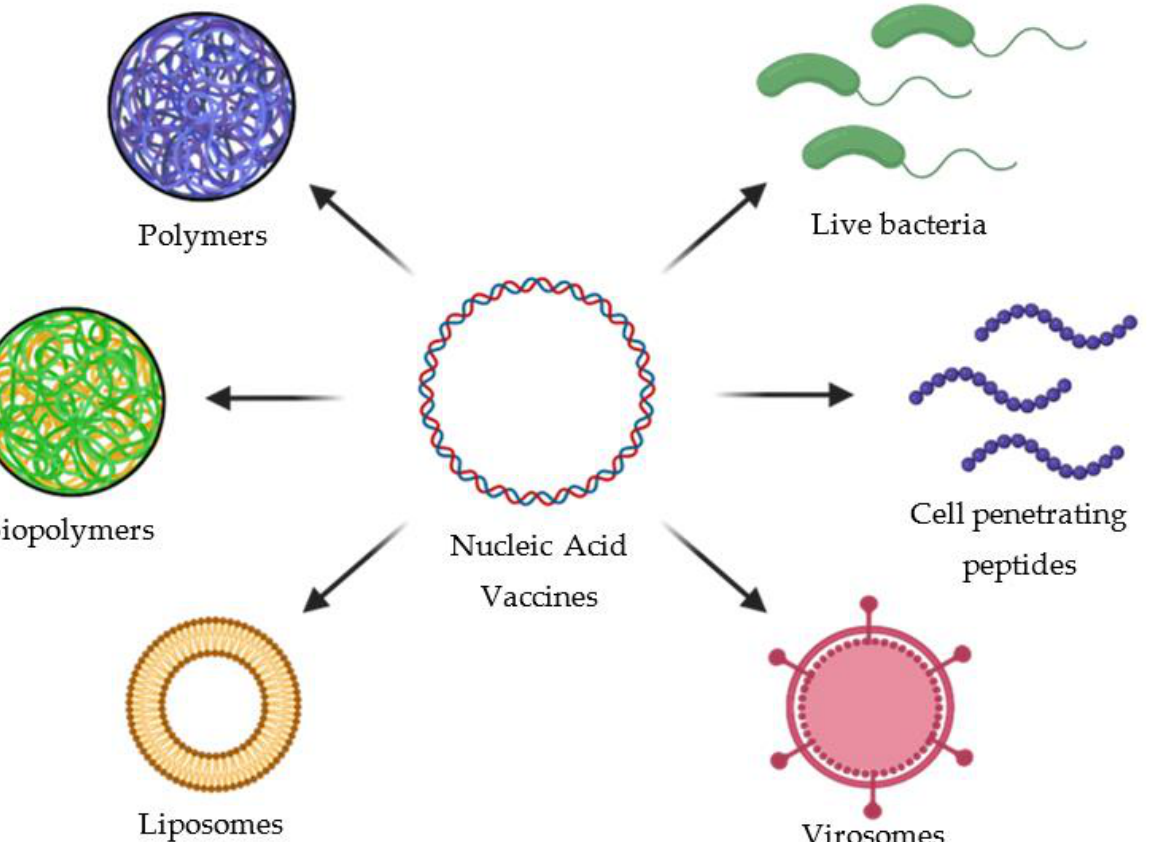
Figure 8. Nucleic acid vaccine carriers. In the figure is shown the most used carriers to deliver nucleic acid-based vaccines such as liposomes, virosomes, polymers, biopolymers, cell penetrating peptides (CPPs) and live bacteria.